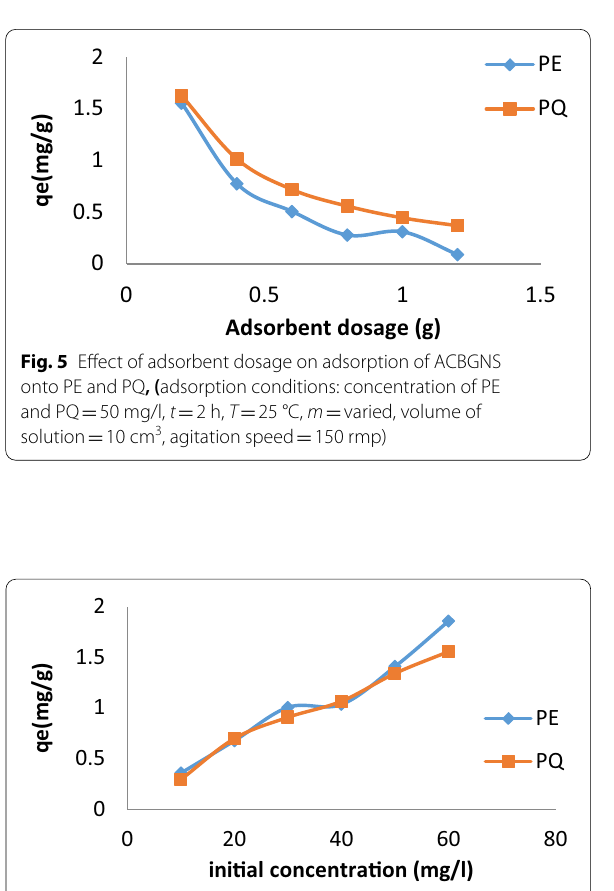
0.2 g, t 2 h, T 25 °C, volume of = = = 150 rmp) =